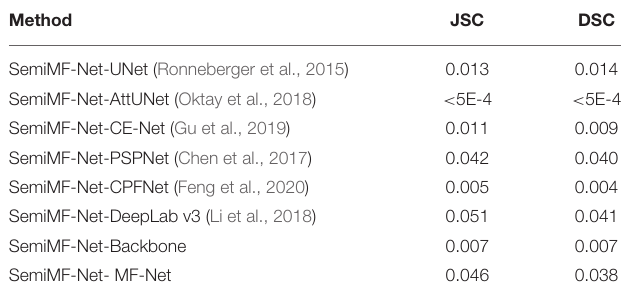
TABLE 4 | Statistical analysis ( p -value) of the proposed SemiMF-Net compared with other CNN-based